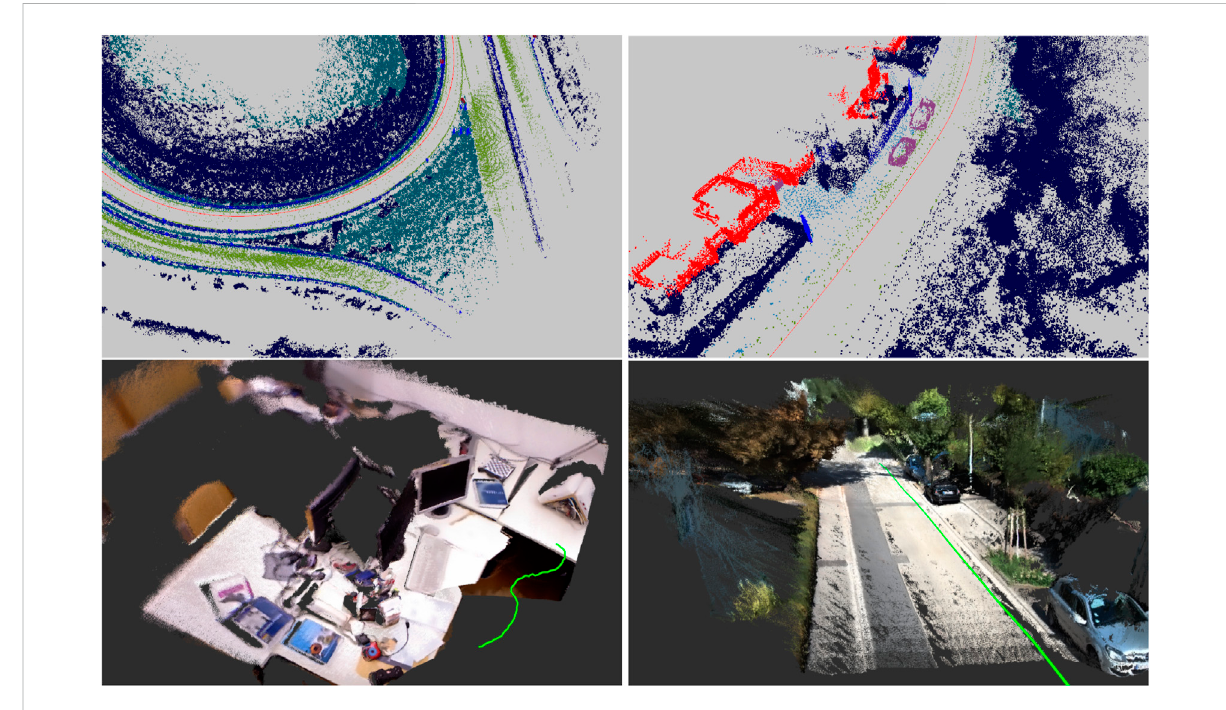
FIGURE 2 Stacked semantic and color point clouds based on frame-to-frame registration results using KITTI (Geiger et al., 2012) LiDAR, TUM RGB-D (Sturm et al., 2012) and KITTI Stereo sensors.